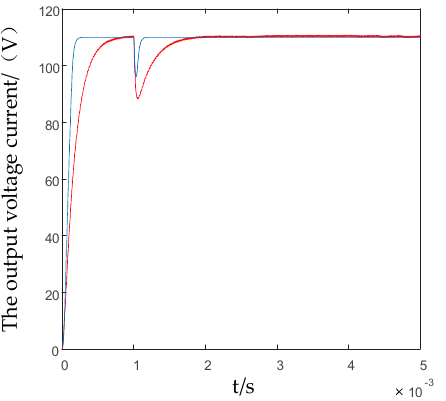
Figure 10. Simulation plot of the output voltage under a single load change.